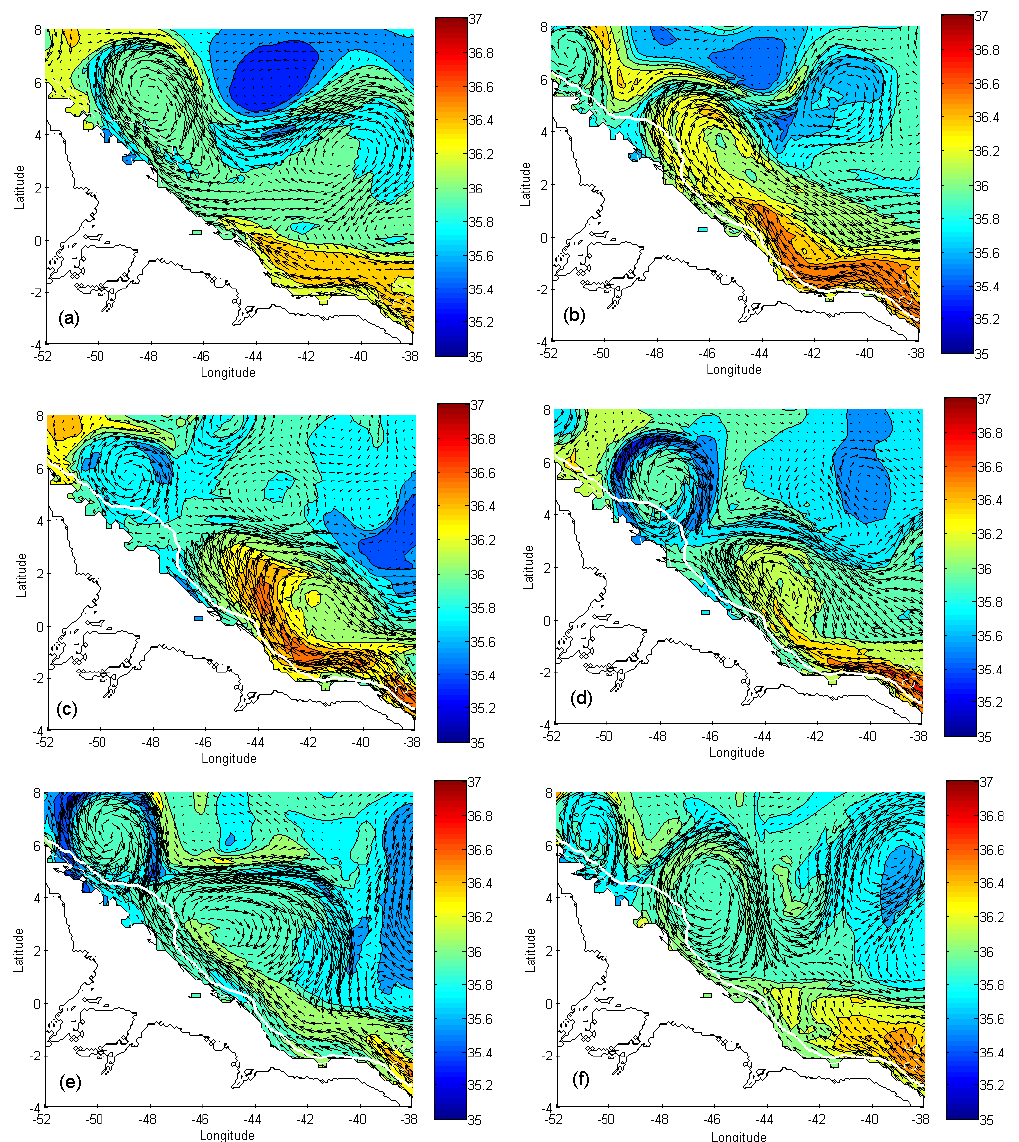
Fig. 6. Seasonal distribution of salinity and velocity from CLIPPER model results at 100m depth for: (a) January 1999, (b) March 1999, (c) May 1999, (d) July 1999, (e) September 1999 and (f) November 1999. Dashed lines represent the isobath